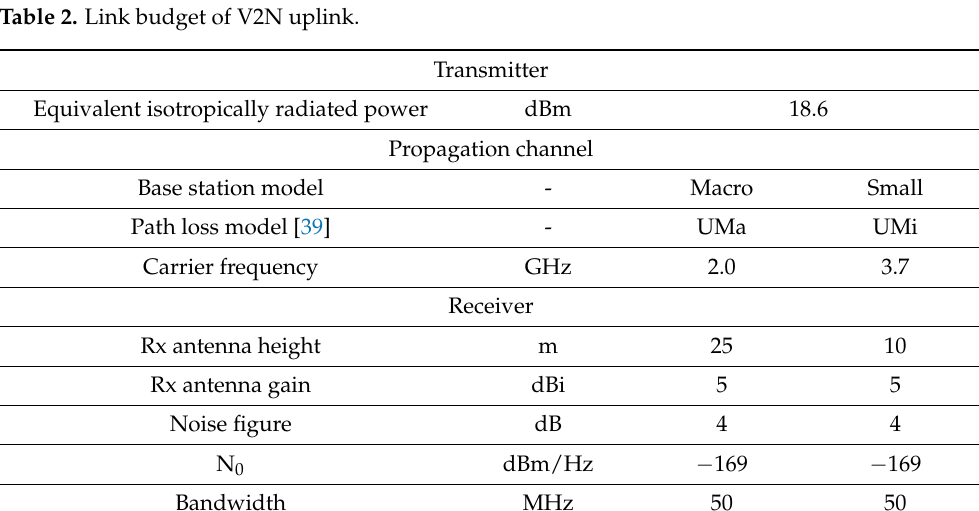
Table 2. Link budget of V2N uplink.